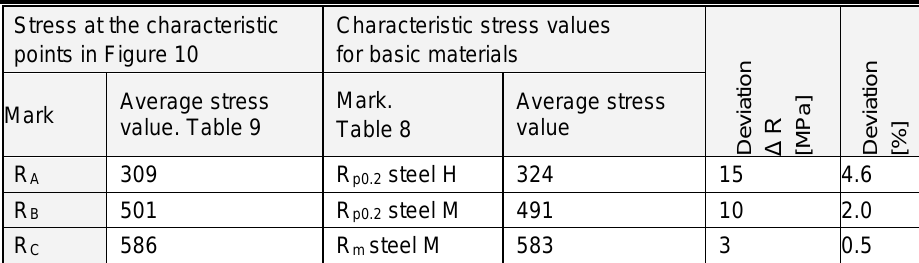
Table 12 – Stresses at the characteristic points of the σ – ε diagram for test tube 2.1 Таблица 12 – Напряжения в характерных точках диаграммы σ – ε эпроветки 2.1 Табела 12 – Напони у карактеристичним тачкама дијаграма σ–ε за епрувету 2.1 Stress at the characteristic Characteristic stress values points in Figure 10 for basic materials Average stress Mark. Average stress value